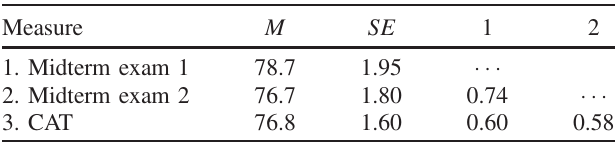
TABLE III. Means, standard errors of the mean, and inter- correlations for scores on exams and CAT. Note that N ¼ 76 , all correlations are significant at p < 0 . 001